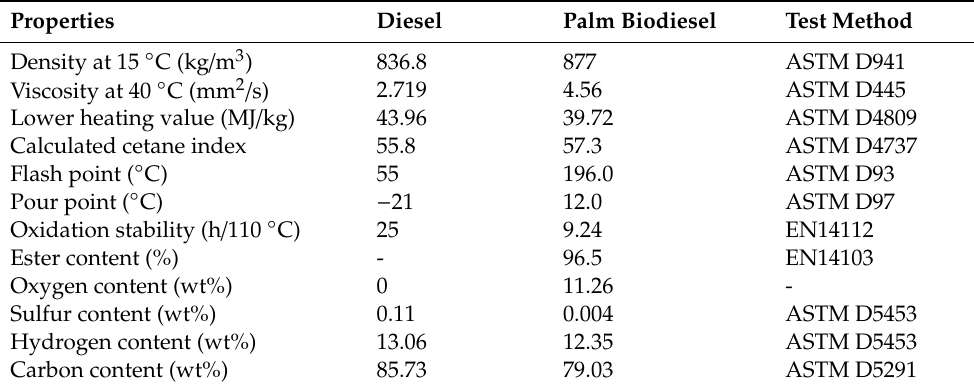
Table 1. Properties of pure diesel and palm biodiesel (PBD).